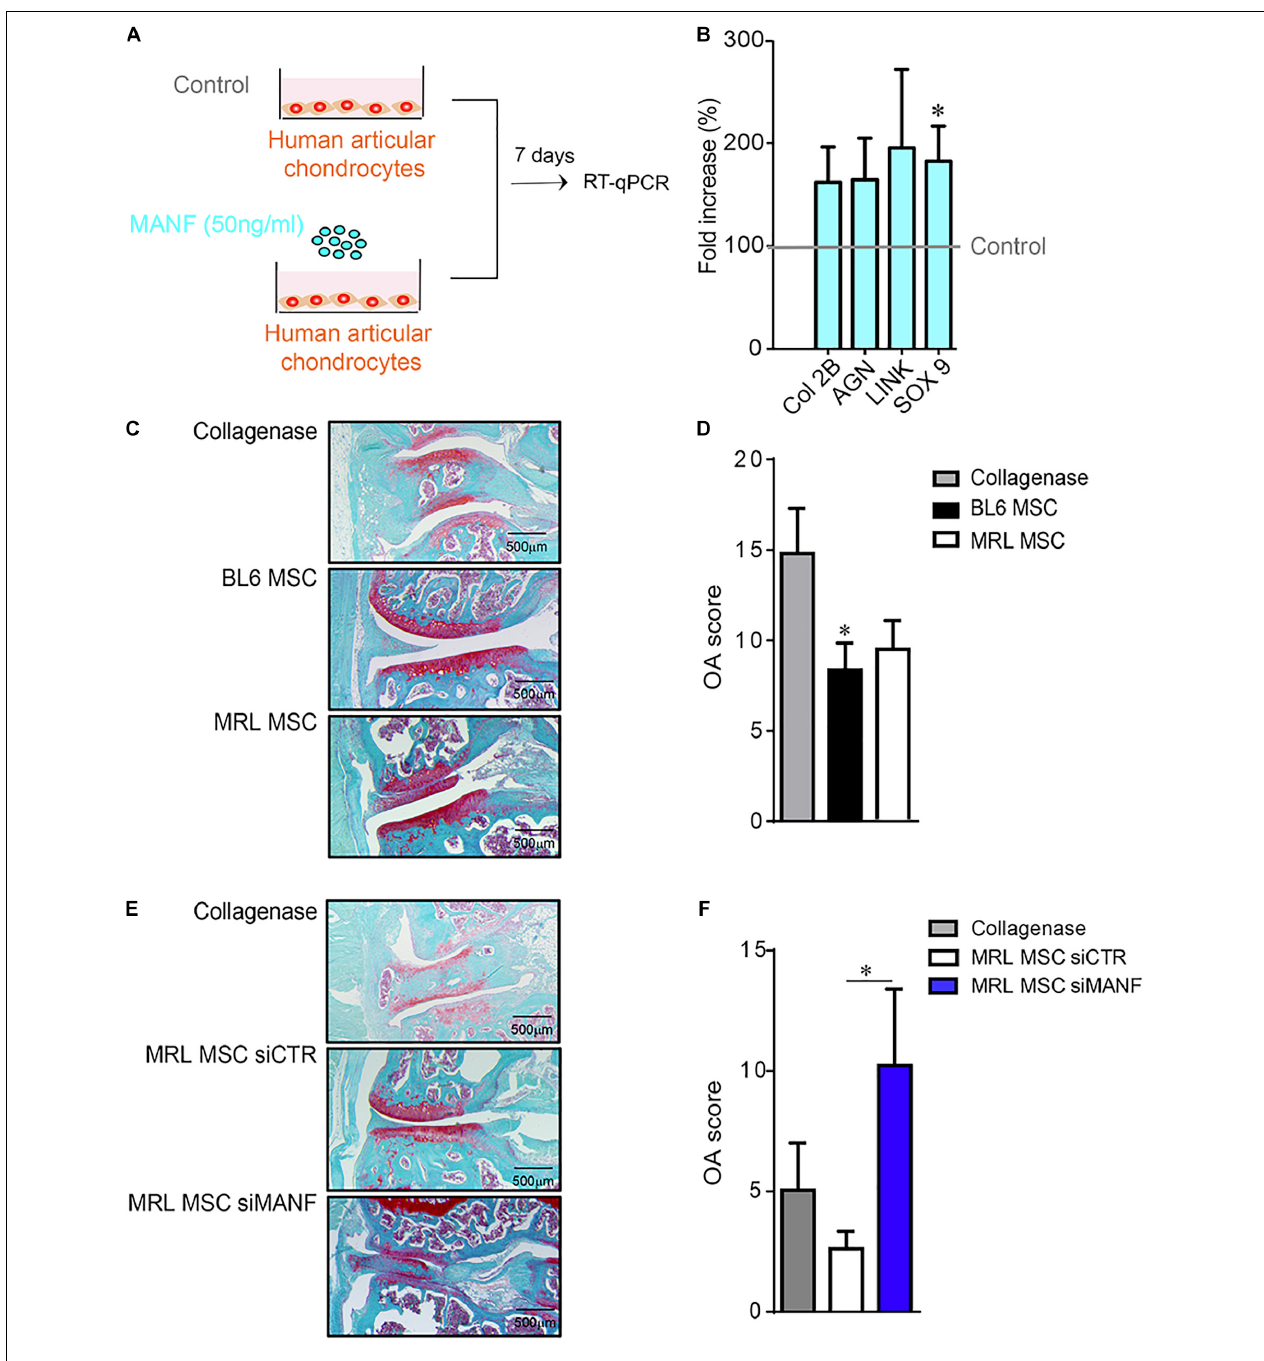
FIGURE 6 | MANF protects chondrocyte from a OA-like phenotype and mice from osteoarthritis. (A) Scheme showing the treatment protocol of human primary chondrocytes with MANF (50 ng/mL) during 7 days. (B) RT-qPCR analysis of chondrocyte anabolic markers such as Col2B, AGN, LINK, and SOX9 expressed in human primary chondrocytes cultured in minimal medium or minimal medium (Control) containing MANF during 7 days. Results are expressed as fold change of gene expression compared to chondrocytes alone (Control) [mean ± SEM ( n = 12 biological replicates)]. *p ≤ 0.05. (C) Histological images of CIOA mice not treated (Collagenase) or treated with BL6 MSC or MRL MSC. (D) OA score of histological sections of knee joints of the mice described in (C) . (C) ( n = 15/group). (E) Histological images of CIOA mice not treated (Collagenase) or treated with MRL MSC transfected with a siCTL (MRL MSC siCTL) or a siMANF (MRL MSC siMANF). (F) OA score of histological sections of knee joints of the mice described in (E) . Results are expressed as the mean ± SEM; *p < 0.05 (Mann–Whitney test; n = 10 mice/group).